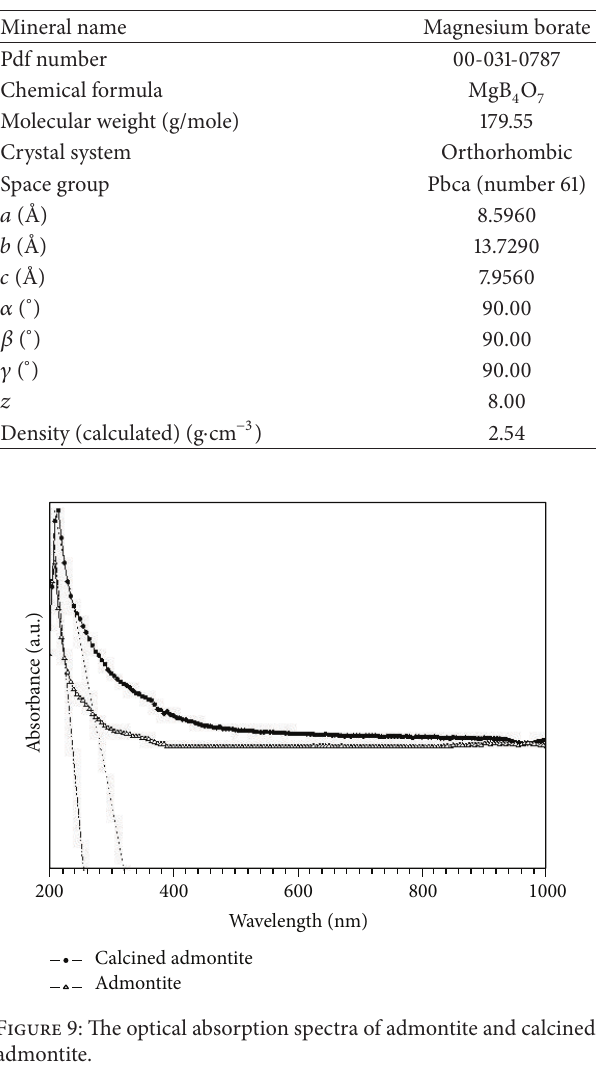
Table 4: Crystallographic data of synthesized magnesium borates.